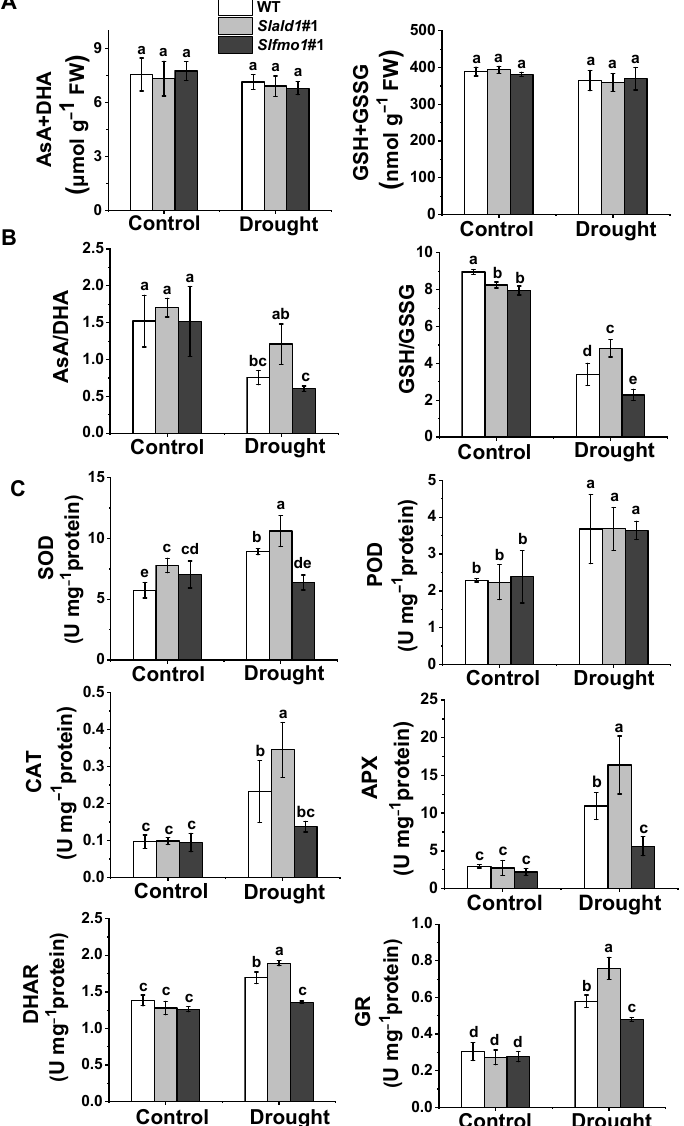
Figure 6. Regulation of cellular redox homeostasis in Slald1 and Slfmo1 mutants under drought. ( A ) Effects of drought treatment on total ascorbate (AsA + DHA) and glutathione (GSH + GSSG) contents, ( B ) Redox status, and ( C ) Antioxidant enzyme activities in mutants and WT plants. The Slald1 , Slfmo1 mutants and WT plants were subjected to control and drought treatment, and the leaves were sampled at 48 h after the initiation of treatment to analyze antioxidant content and enzyme activity. APX, ascorbate peroxidase; AsA, reduced ascorbate; CAT, catalase; DHA, dehydroascorbate; DHAR, dehydroascorbate reductase; GR, glutathione reductase; GSH, glutathione; GSSG, glutathione disulfide; POD, peroxidase; SOD, superoxide dismutase. The data are presented as mean values ± SD, n = 4. Different letters (a, b, c, d, e) above each bar indicate significant differences at p < 0.05 (Tukey’s test) among treatments.